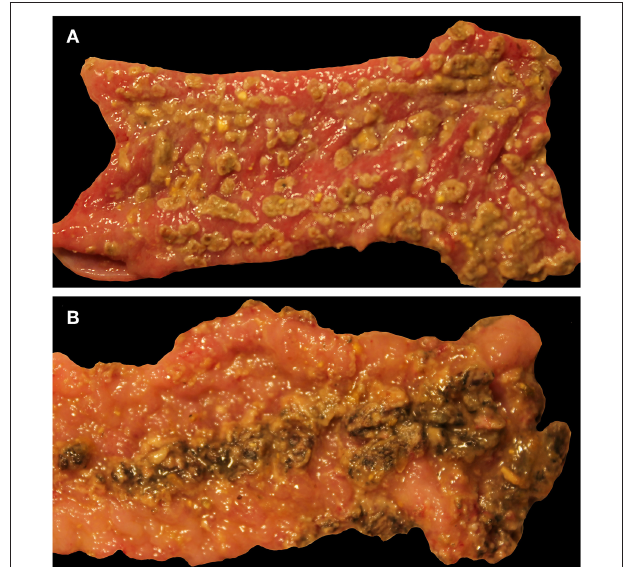
FIGURE 7 | Representative gross lesions following infection with Salmonella 4,[5],12:i:- and Salmonella Typhimurium. Spiral colon. (A) Pig inoculated with Salmonella 4,[5],12:i:-, DPI 4, severe diffuse fibrinous colitis. (B) Pig inoculated with Salmonella Typhimurium, DPI 4, severe diffuse fibrinous colitis. spiral colon for all serovars. On DPI 2 ( Figure 8 ), there were statistically significant differences in histologic lesion scores in the ileum, cecum, and spiral colon. In the ileum, S. 4,[5],12:i:- had induced significantly higher histologic lesion scores than the sham-inoculation and S. Derby but not more severe than